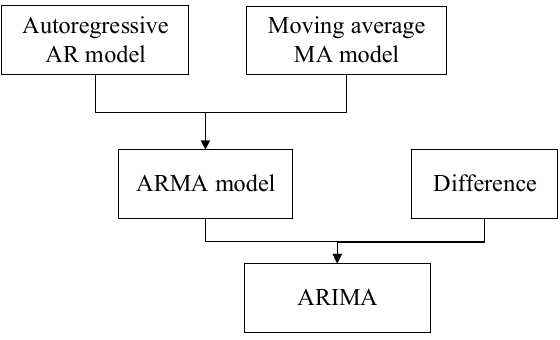
Figure 2. The relationship between ARMA and ARIMA .